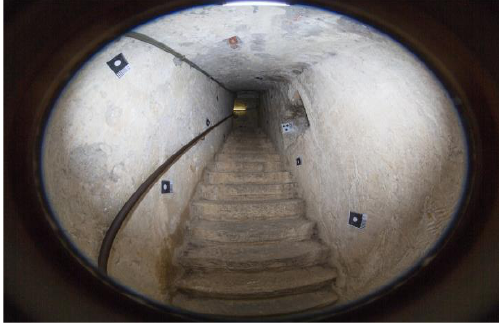
Figure 4: Front capture of the runner at the Castle.